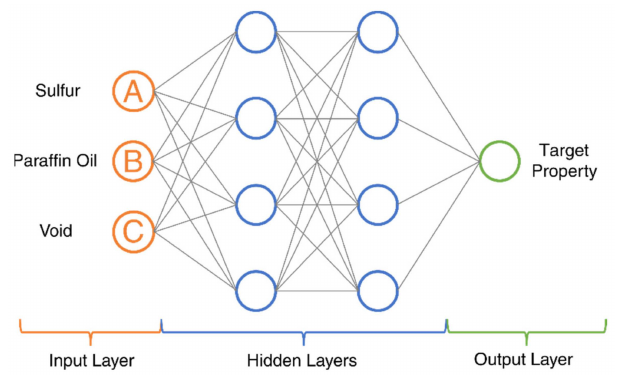
Figure 7. ANN basic